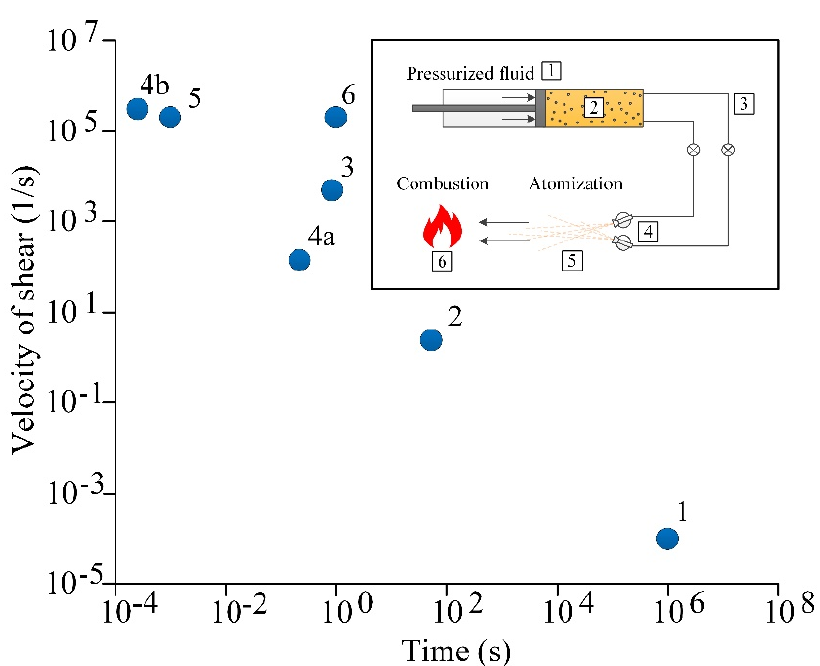
Figure 2. Shear rate and characteristic time of the stages implementation of the typical gel fuel life cycle [45,112–115]: 1—storage; 2—moving from the fuel tank to the transport channel; 3—moving in fuel line; 4—atomization with nozzle (4a) or hydraulic nozzle (4b); 5—movement of fuel fragments (particles or droplets) in the combustion chamber; 6—melting, evaporation and combustion of fuel. At the third stage, the shear rate recorded under the conditions of the movement of gel fuel through the pipeline at a speed of 2.4 m/s for 0.84 s is 4.8 × 10 3 s − 1 . depends on the method of atomization and the design of the corresponding spray